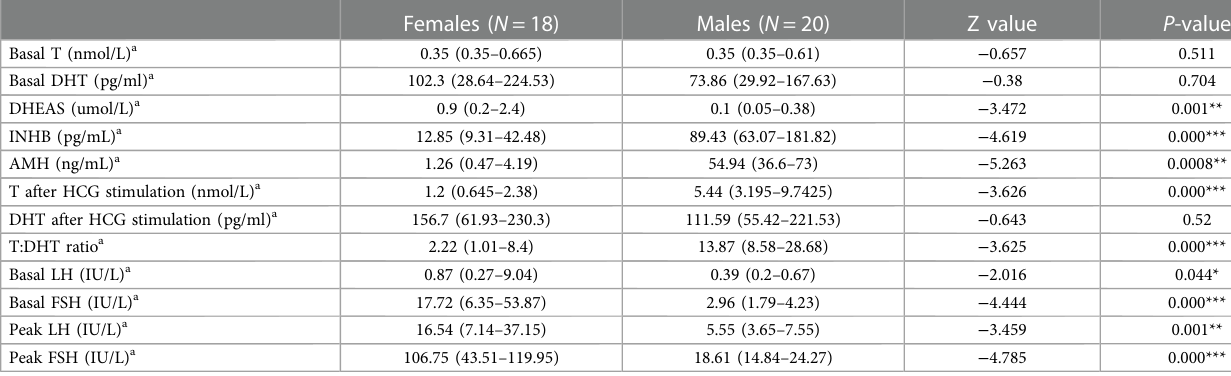
TABLE 4 45,X/46,XY mosaicism male and female hormone levels.